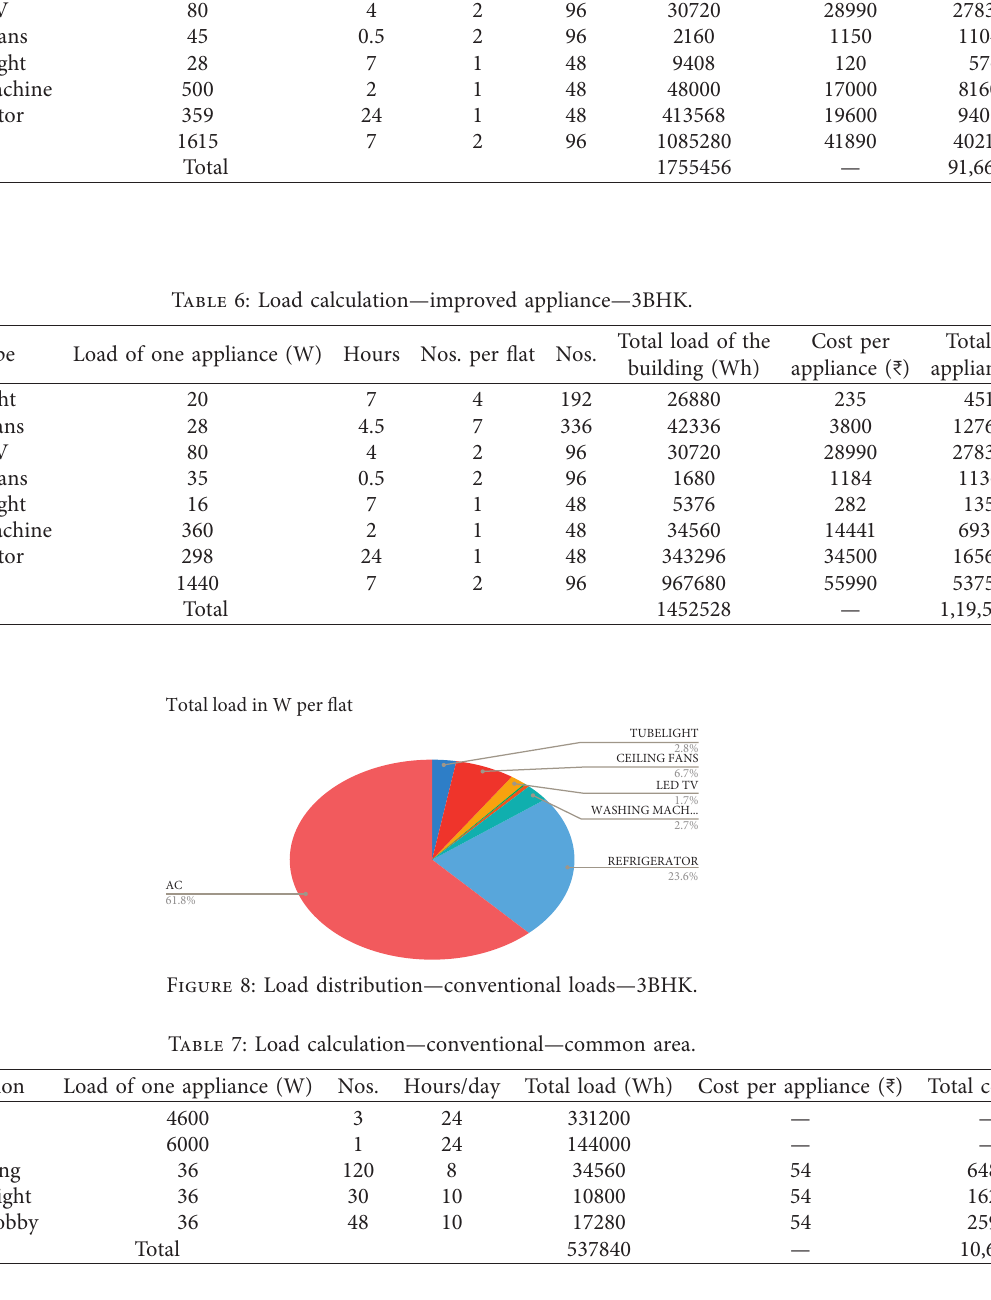
Table 8: Load calculation—improved appliances—common area.